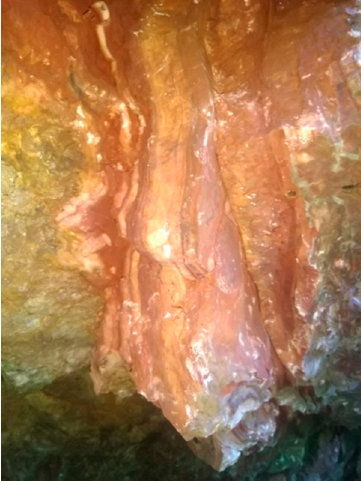
Figure 9. Volcanic thermal sinter (Böttinger marble) (Author 2020).